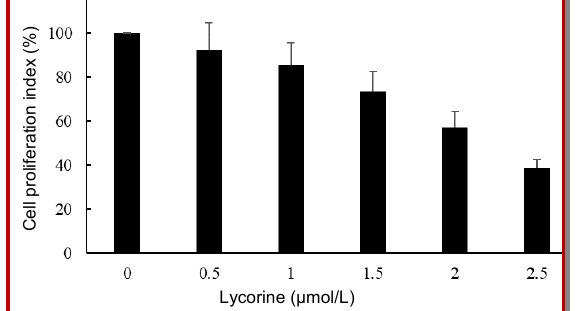
Figure 1: Lycorine suppresses proliferation of MDA-MB-231